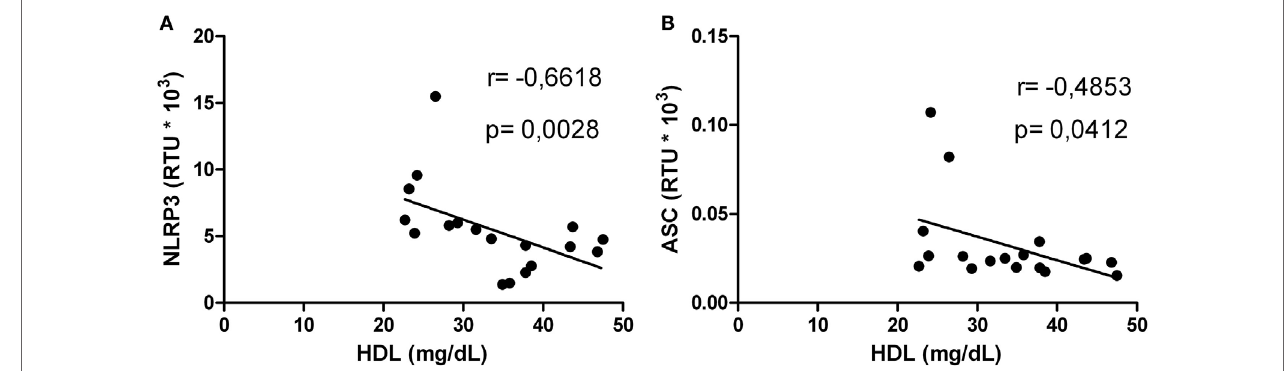
FigUre 6 | Correlation analysis between high-density lipoprotein (HDL) and NLRP3 or ASC in human immunodeficiency virus type 1-infected individuals. Correlation between HDL and NLRP3 (a) or ASC (b) in patients with viral load greater than 5,000 copies/mL was performed using a Spearman test. The r and p values are indicated in each figure. A p value lower than 0.05 was considered as significant